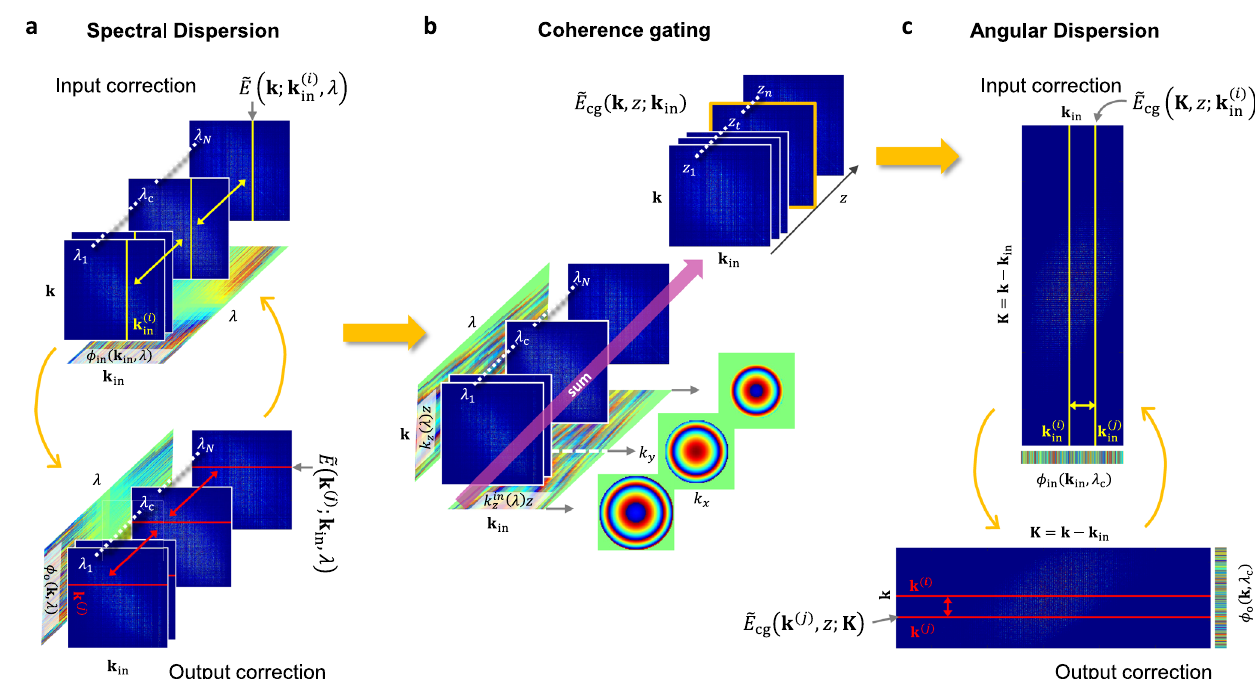
Fig. 3 | Proceduresfor fi nding spectro-angular dispersion. a Spectral dispersion (cid:5) (cid:6) of different wavelengths are marked with correction. For a given k ð i Þ in , e E k ; k ð i Þ in , λ yellow lines. We compute correlations (yellow arrows) among the column vectors to fi nd the input spectral dispersions. Likewise, we compute correlations (red (cid:5) (cid:6) arrows)amongtherowvectorsindicatedbytheredlines, e E k ð j Þ ; k in , λ ofdifferent wavelengths for a given k ð j Þ , to fi nd the output spectral dispersions. Input and outputcorrectionsareiterateduntiltheyareconverged. b Coherencegating.After (cid:1) (cid:3) for a set of target depths z are obtained by spectral corrections, e E cg k , z ; k in integrating e E k ; k in , λ